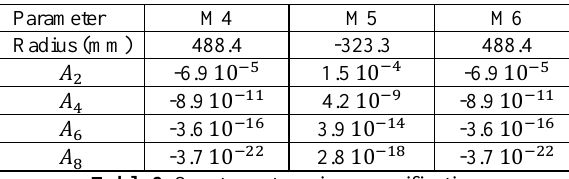
Table 8. Spectrometer mirror specifications